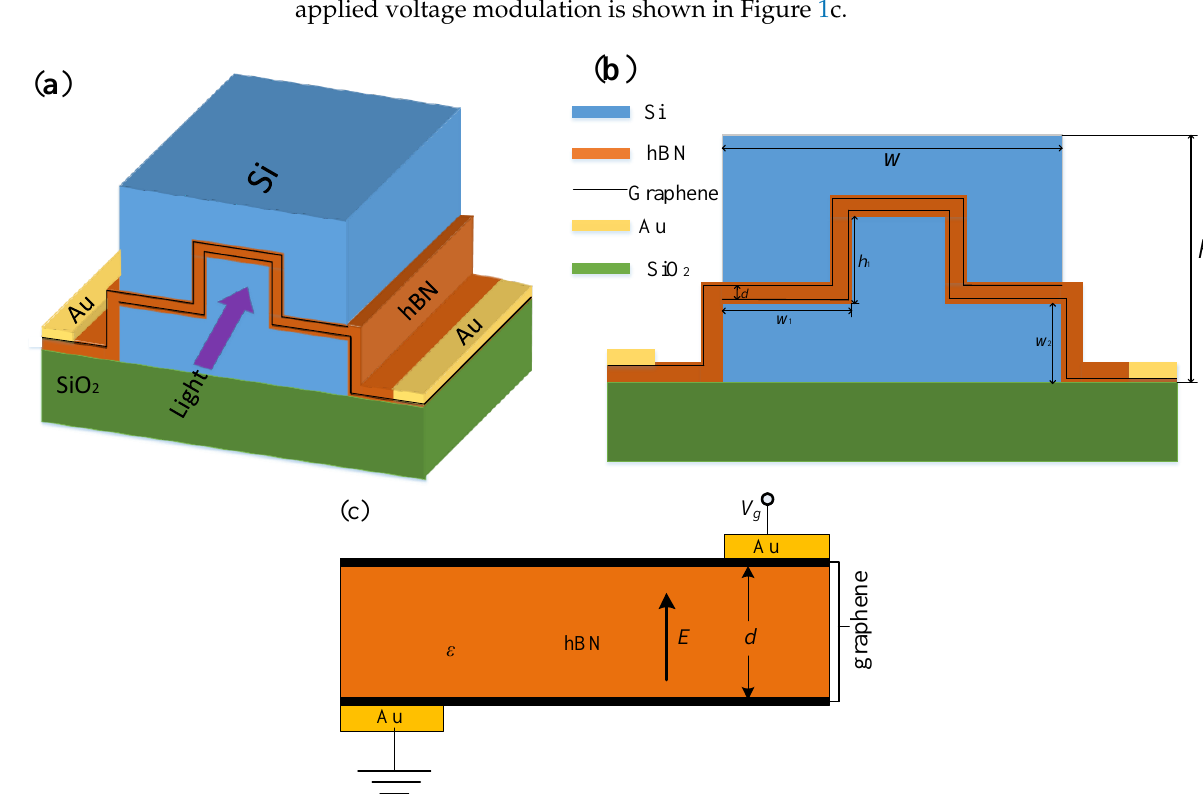
Figure 1. The structure of the polarization-independent graphene optoelectronic modulator ( a ) three-dimensional structure diagram ( b ) schematic diagram of waveguide cross-section structure ( c ) the diagram of applied voltage modulation.